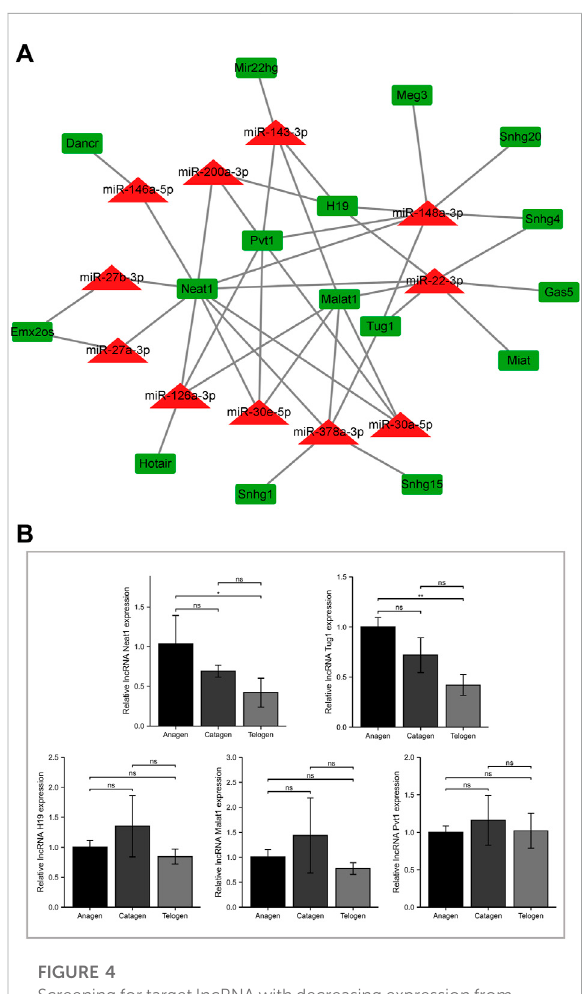
FIGURE 4 Screening for target lncRNA with decreasing expressionfrom the anagen to telogen phase in murine hair follicle cycle. (A) Construction of the miRNA-lncRNA network. The miRNA-lncRNA interactionswereexperimentallyvalidatedinpreviousstudies or predicted using bioinformatic tools. (B) Validation of screened lncRNAs using RT-qPCR. The expression of lncRNA H19, Malat1, Neat1, Pvt1, and Tug1 at different stages of murine hair follicle cycle. ns, p ≥ 0.05; *, p < 0.05; **, p <